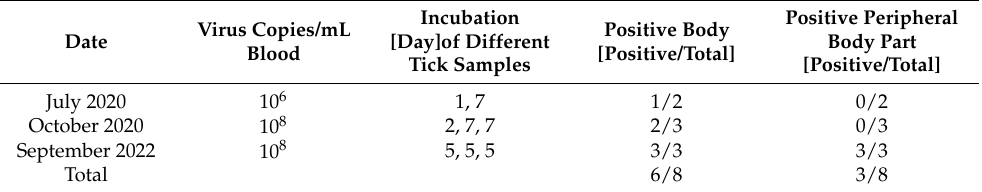
Table 3. Results of feeding experiments of I. ricinus ticks with ALSV infected blood.